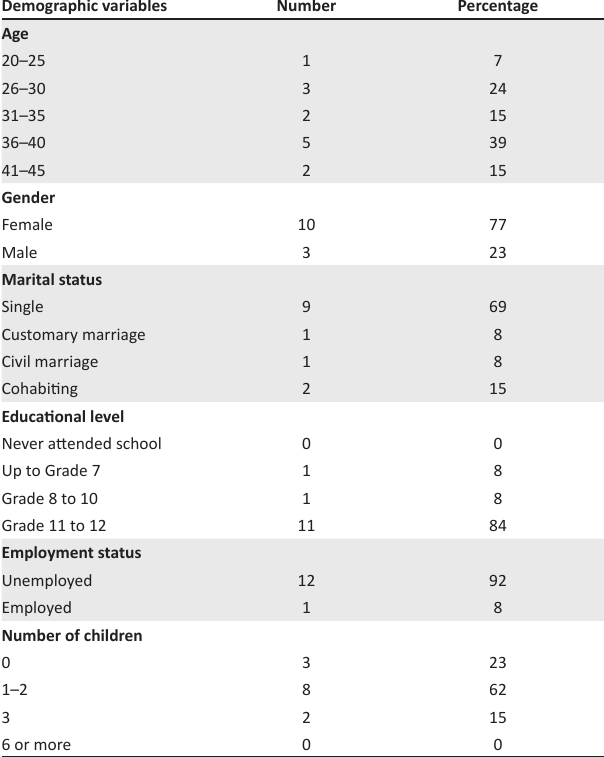
TABLE 1: Demographic data of